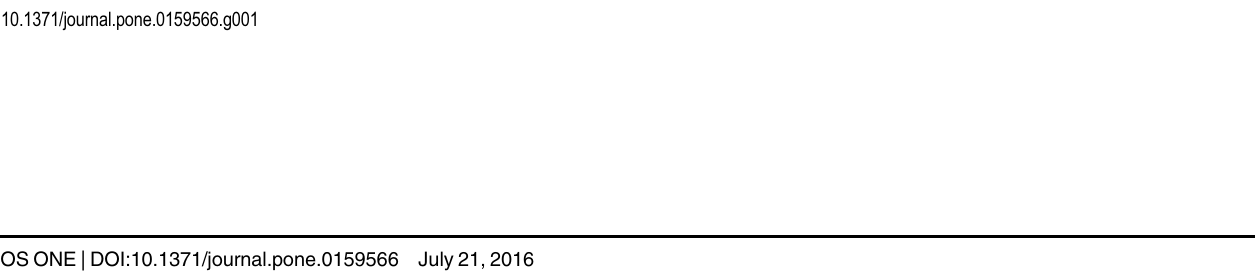
PLOS ONE | DOI:10.1371/journal.pone.0159566 July 21,